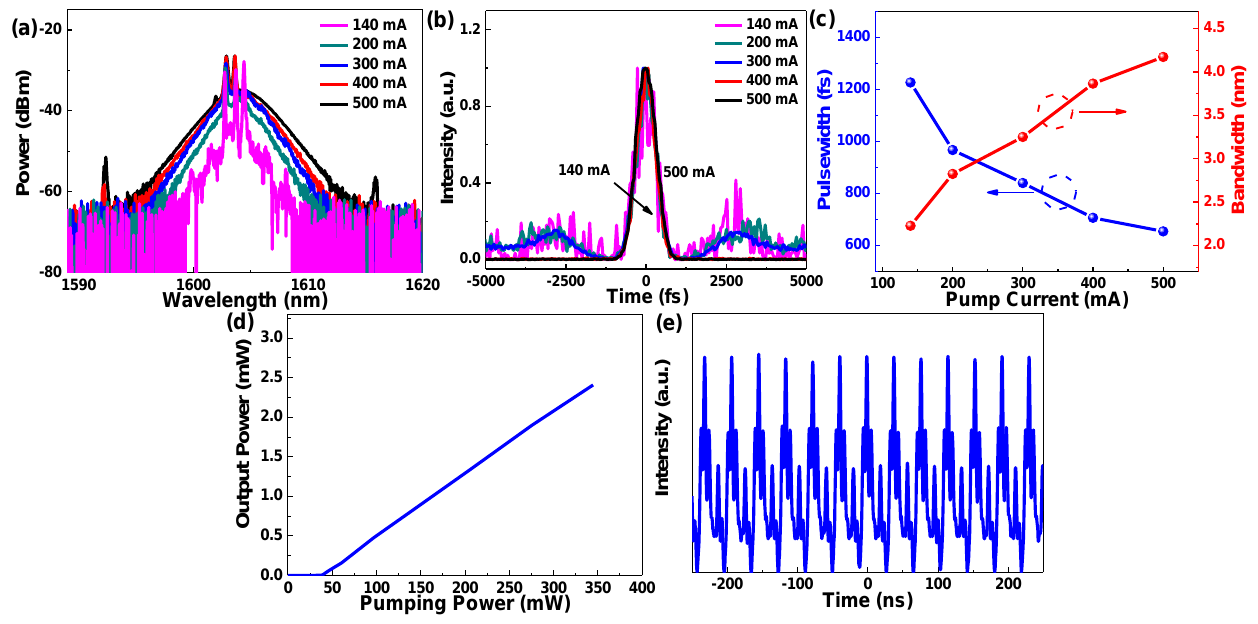
Figure 6. ( a ) Autocorrelated traces and ( b ) corresponding optical spectra of the mode-locked pulse self-started by the Ge-based SA. ( c ) Pulsewidth and bandwidth of the mode-locked pulse self-started by the Ge-based SA under different pumping currents. ( d ) P–I curve and ( e ) pulse train of the mode-locked pulse self-started by the Ge-based SA. Table 2. Comparison of the mode-locking performances of the Ge SA and our previous work [55]. Materials